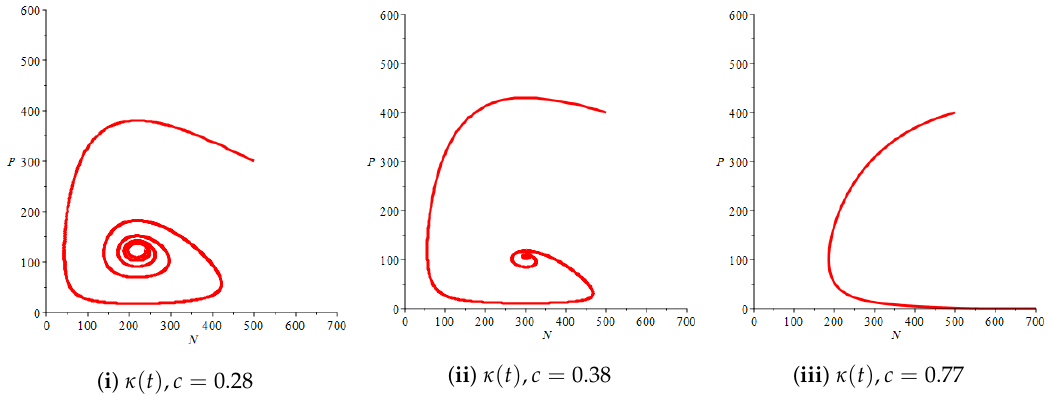
Figure 11. Effect of the bifurcation parameter on the phase space of the prey–predator model with Holling type II functional response with κ 1 = 300, κ 2 = 500, r = 0.3, a = b = 0.0025, γ = 0.002, m = 0.2, α =